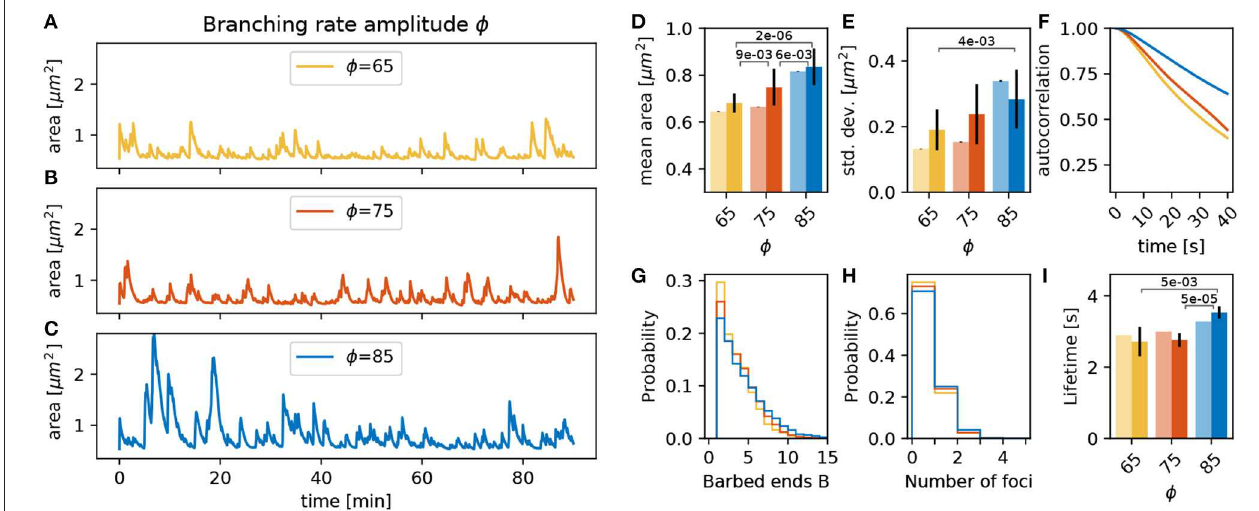
65, (B) φ 75, and (C) φ 85. = = =